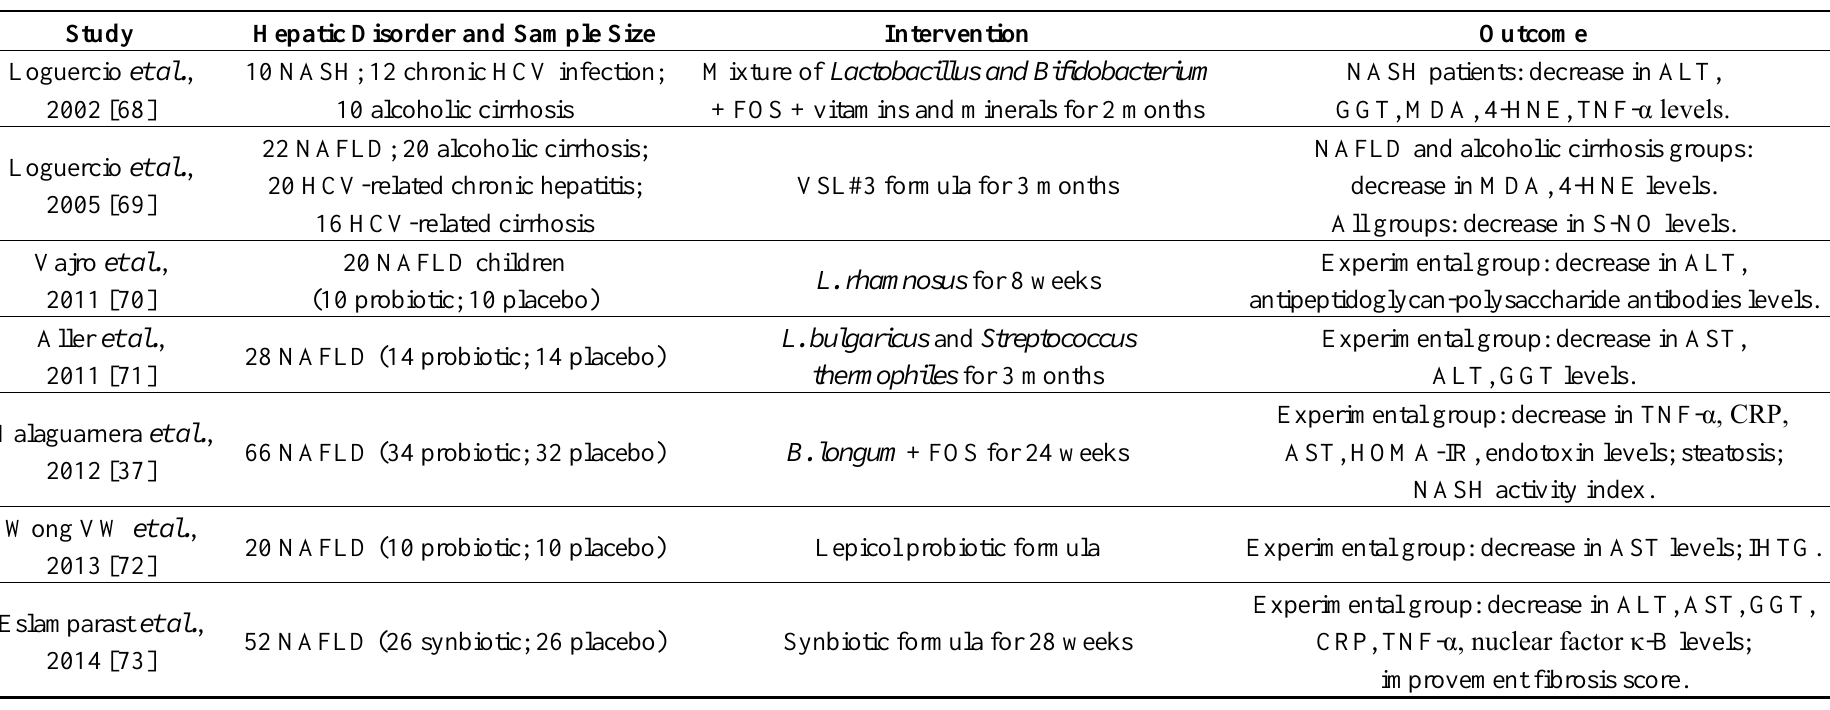
Table 2. Summary of clinical trials using probiotics to treat